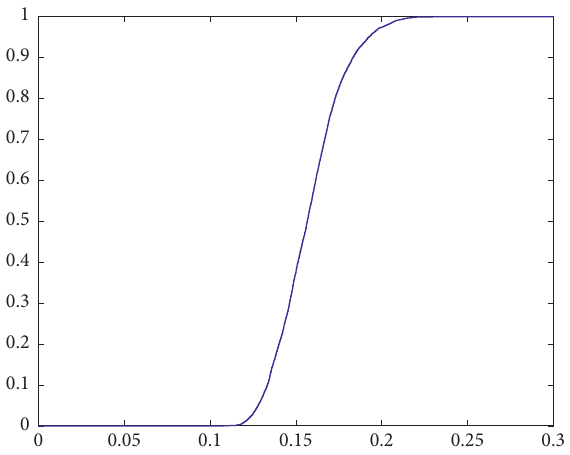
Figure 7: IH -VPIN cumulative distribution function.